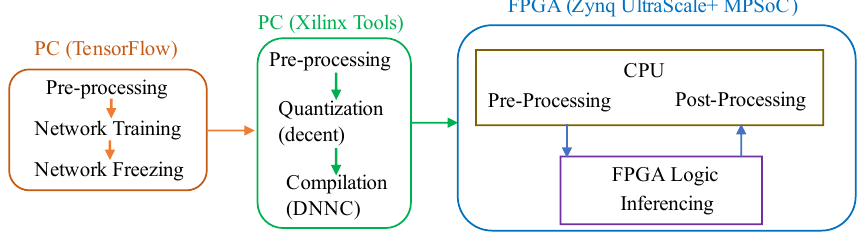
Figure 13. FPGA Inference